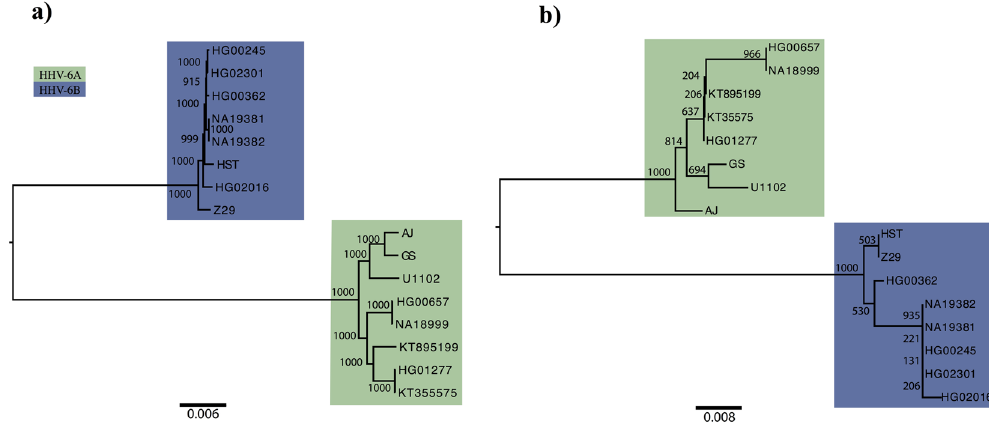
Figure 1. Species assignation through Neighbor-joining tree. The trees were built using the whole HHV-6 data set ( a ), and using only the U83 ORF ( b ). The different virus species are colour-coded, showing the clear separation between HHV-6A and HHV-6B strains. U83-based tree presents lower bootstraps due to the low number of variants present in the limited U83 region.